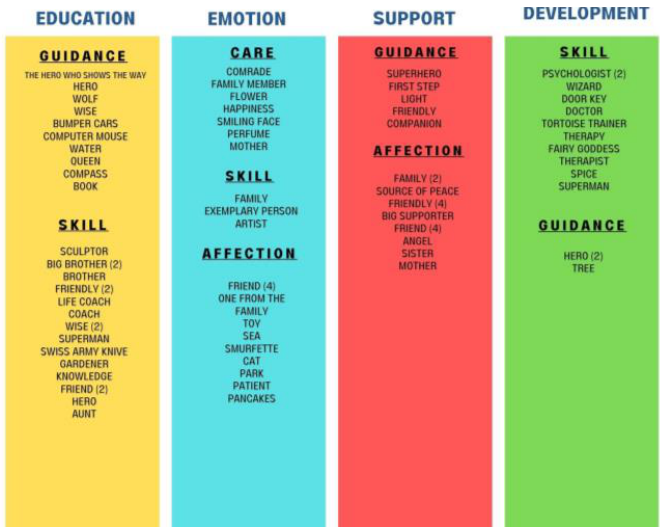
Figure 2. Parents’ metaphors about educators. Themes, categories, and codes that emerged because of the metaphors produced by the families participating in the research for “educators” are presented in Figure 2.